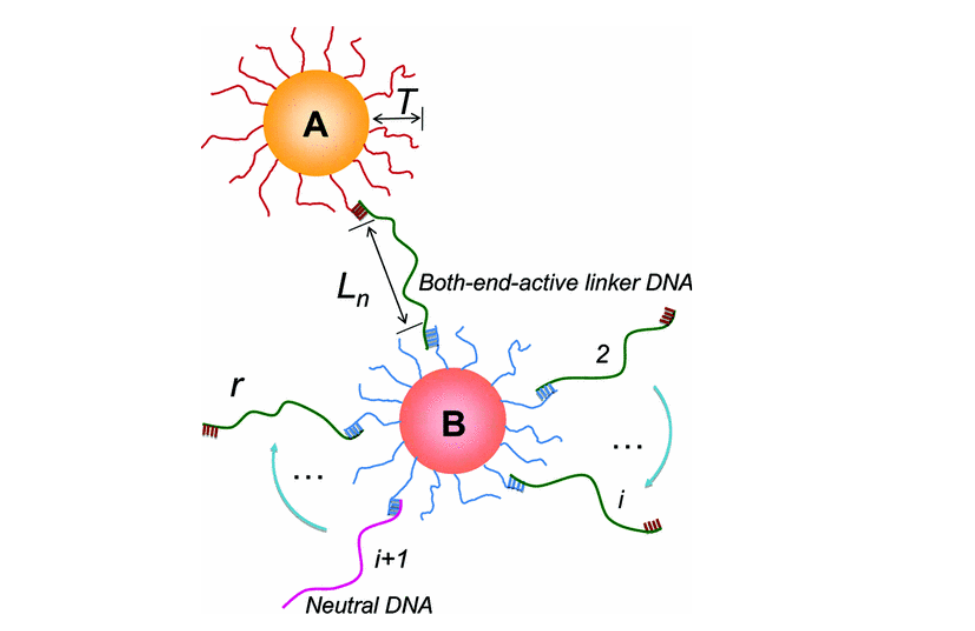
Figure 2. A schematic representation of linker-mediated binding of DNA-grafted particles proposed by Xiong et al. The system, with core particles A and B, has two types of linkers: linkers with both ends active called the active linkers and linkers with just one end active that are called as neutral DNA. The length of the linkers is denoted by L n , r is the total number of linkers that each particle connects to, via the hybridization of the sticky ends of the grafts. The linkers have 15 base long recognition sequence on both the ends and n represents the length of central flexible polythymine. Reprinted with permission from [44] copyright 2009 by American Physical Society.